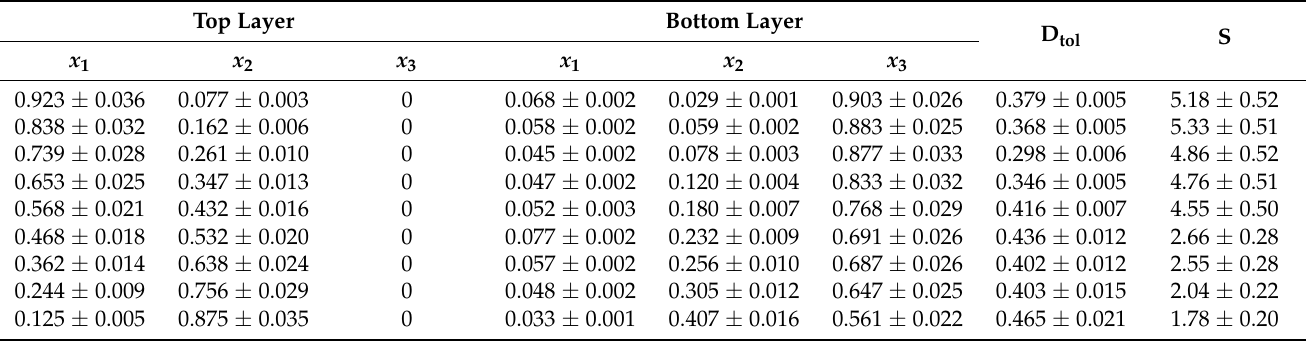
Table 6. Composition of the experimental tie-lines (mole fraction), the toluene distribution ratio (D) and selectivity (S) for the ternary system {1-hexene (1) + toluene (2) + DES #1 (3)} at 298.15 K and 101.325 kPa a